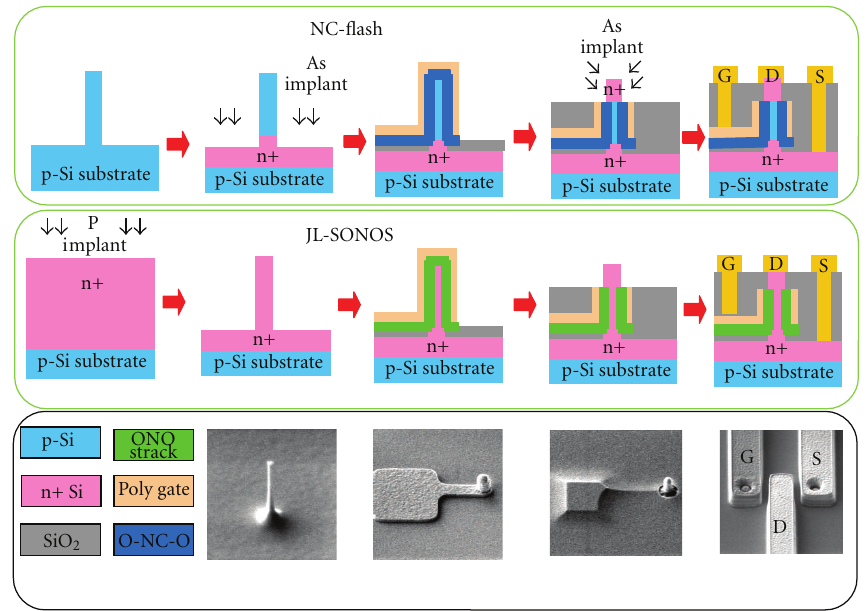
Figure 11: (a) Process integration flow of vertical SiNW junction-based NC-Flash: (a-1) vertical SiNW formation; (a-2) As is implanted to form the source; (a-3) gate stack deposition (O - N - O or O - NC - O for SONOS and NC-flash, resp.) and gate pad definition; (a-4) tip poly and O-NC-O removal, followed by drain implant; (a-5) metallization; (b) process integration flow of vertical JL-SONOS: (b-1) bulk implant and annealing; (b-2) vertical SiNW formation; (b-3) gate stack deposition and gate pad definition; (b-4) tip poly and ONO removal; (b-5) metallization; (c) tilted top view SEM image of SONOS/JL-SONOS fabrication during key process steps (left to right): vertical SiNW formation; gate pad definition; tip poly and ONO removal; metallization. (Reprinted with permission from [45]. [2011]